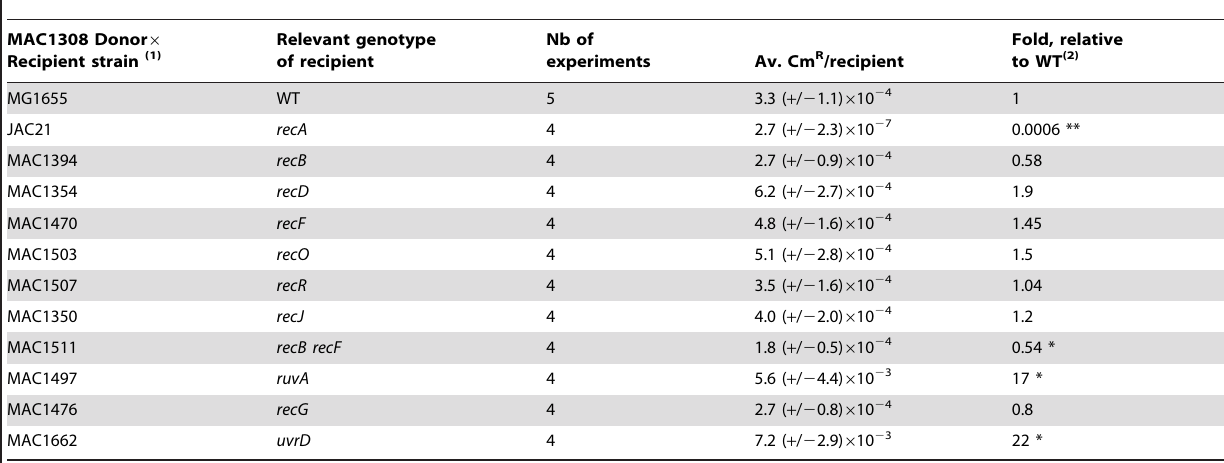
Table 4. Recombination frequencies with circular pJA2 in E. coli mutant derivatives.